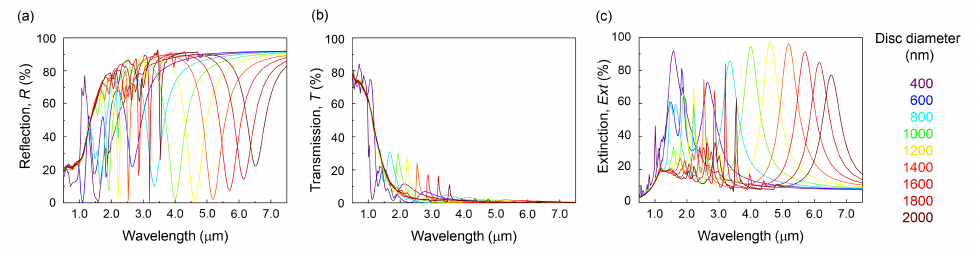
Figure 5. Numerical simulations. ( a ) Reflectance R , ( b ) Transmittance T , and ( c ) Extinction Ext = 1 − ( R + T ) spectra. FDTD simulations for ITO metasurfaces with the plasma model with ε ∞ = 4.4, ω P = 3.36 × 10 15 rad/s, Γ = 1.05 × 10 14